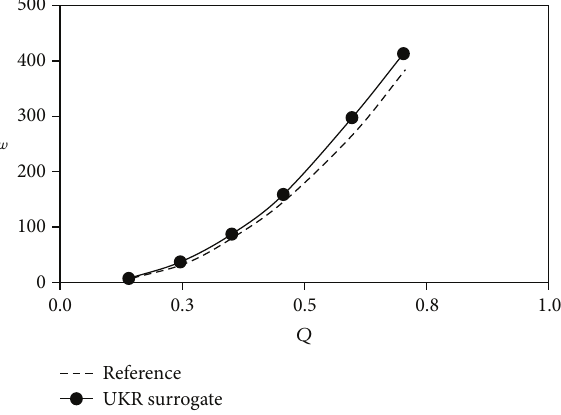
Figure 7: Effect of flow rate on power.